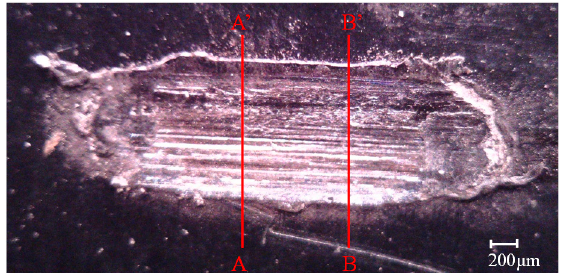
Figure 3. Measurement path on the worn surface of an electrodeposited coating in high-strength steel substrate.